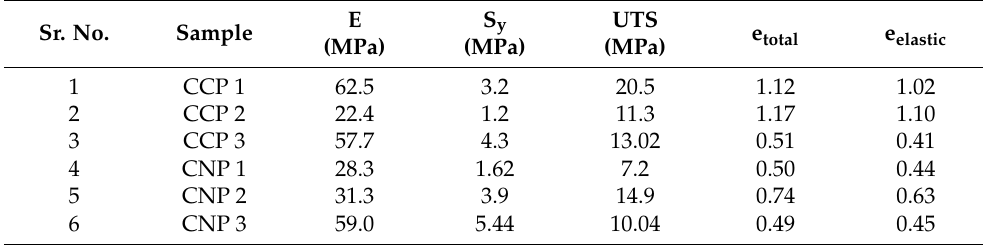
Table 3. Summary of mechanical properties of composites. Sr.